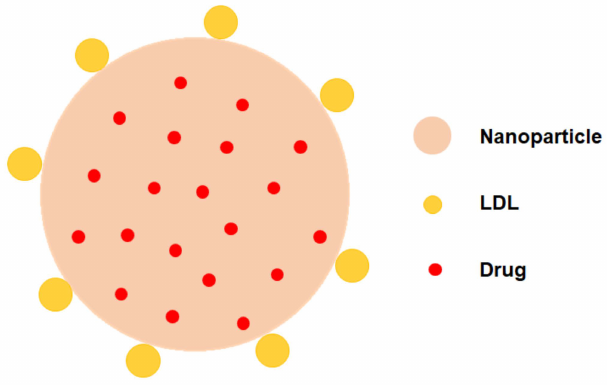
Figure 5. Model diagram of LDL-NPs. The NP core is loaded with small molecule drugs, and the LDL is attached to the outer layer of the NP as a targeting